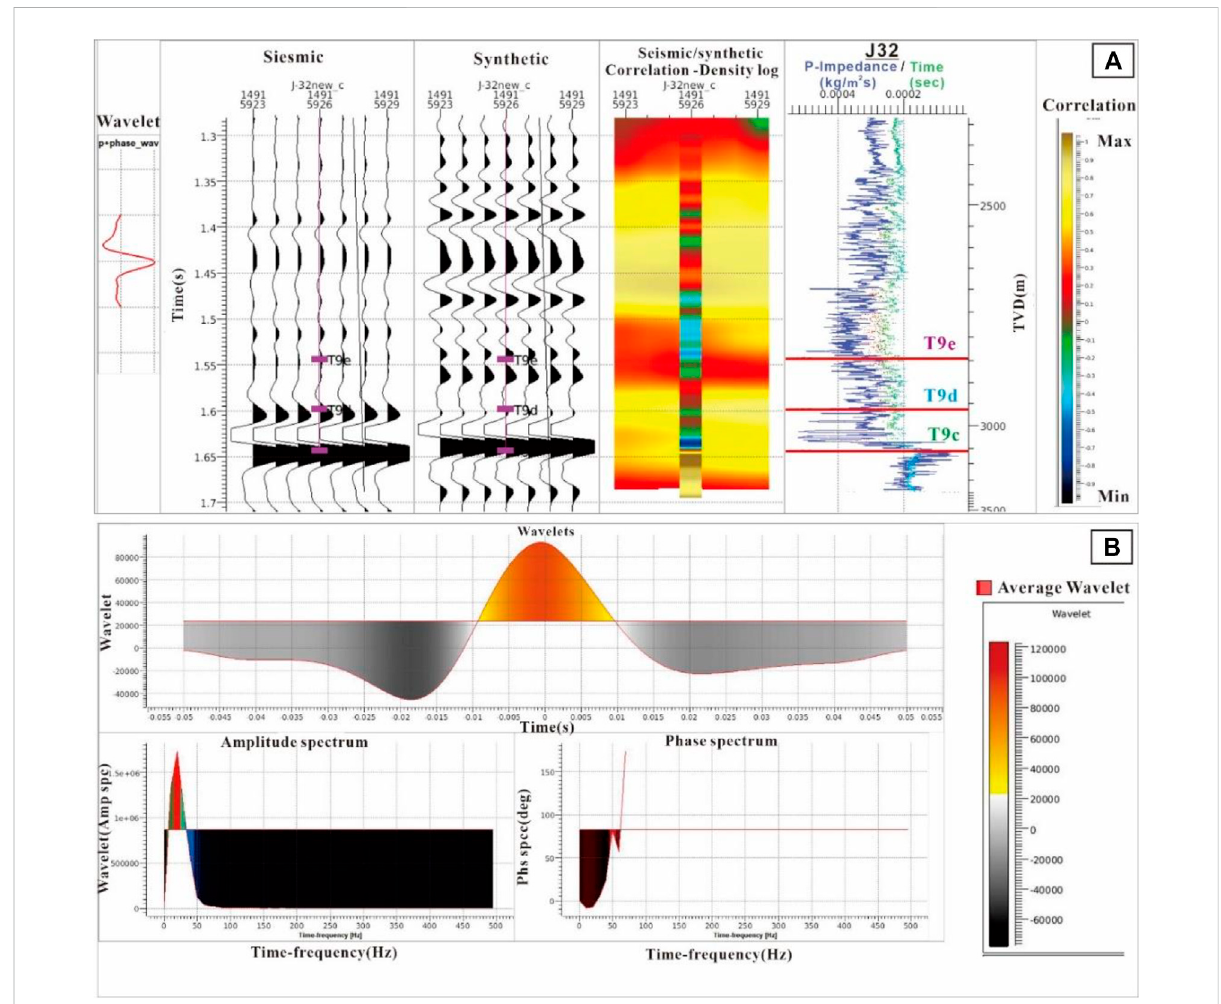
FIGURE 5 (A) The well editing window shows the synthetic seismogram utilizing the well J32. The fi rst panel shows seismic data from well traces. The second and third panels show synthetics, third shows the correlation between the seismic and synthetics. The highest value shows a good correlation, whereas the lowest value shows a minimum correlation. An overlay log on the correlation panel shows the variations of the RHOB log within ZOI. The last and fourth panel shows the time and P-impedance log of well J32. (B) An average wavelet along with amplitude and phase spectrums were made by utilizing the wavelets of all the studied